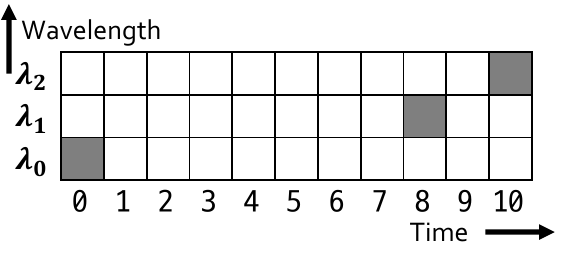
Figure 9. The proposed LIDAR scanner uses carrier-hopping prime codes with three wavelengths and 11